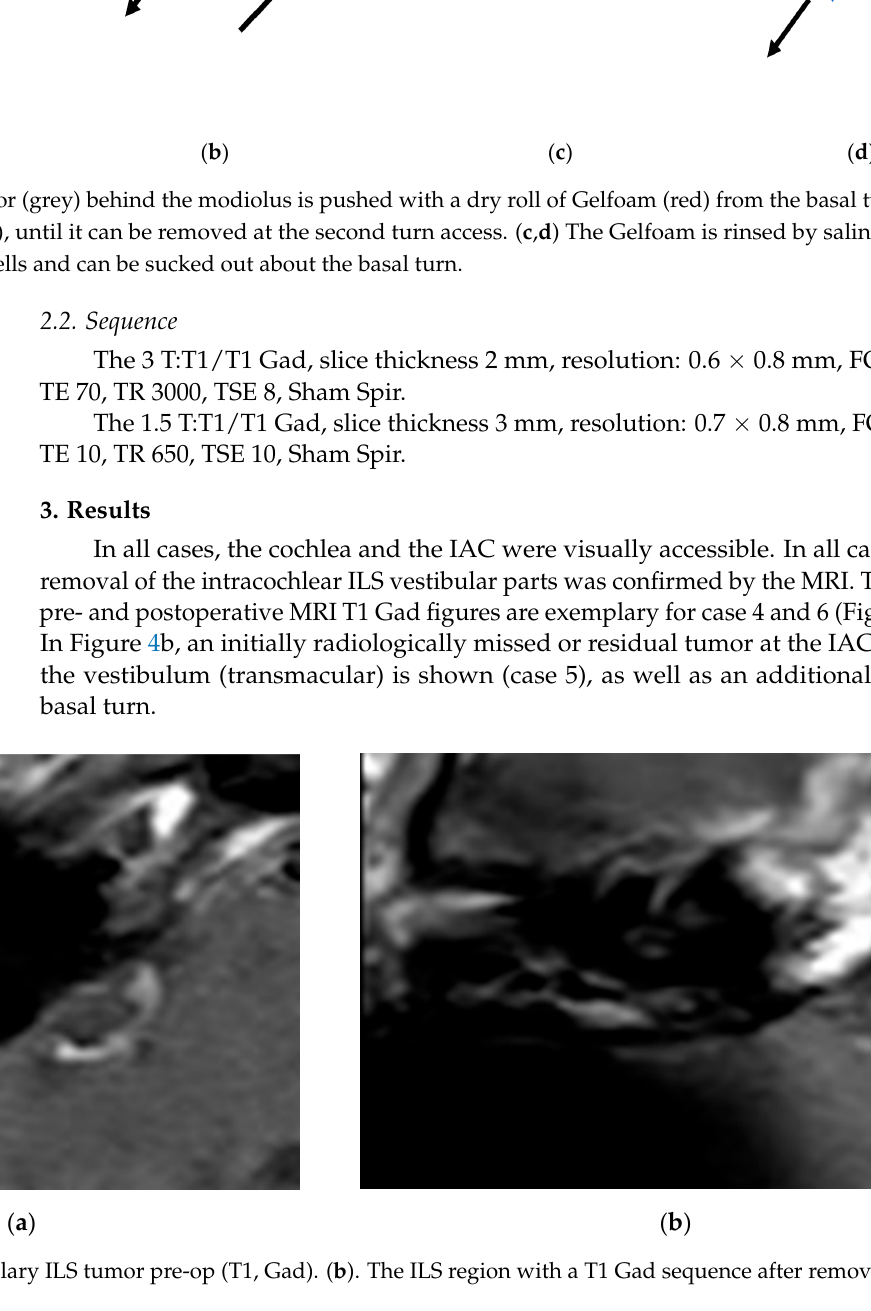
( b ) Figure 3. ( a ) . The exemplary ILS pre-op (T1, Gad); ( b ) . The ILS region with a T1 Gad sequence after removal and CI. ( a ) ( b ) Figure 4. ( a ) . An exemplary ILS tumor pre-op (T1, Gad) ( b ) . The ILS region with a T1 Gad sequence after removal and CI and detection of a possible tumor in the IAC and in the basal turn.